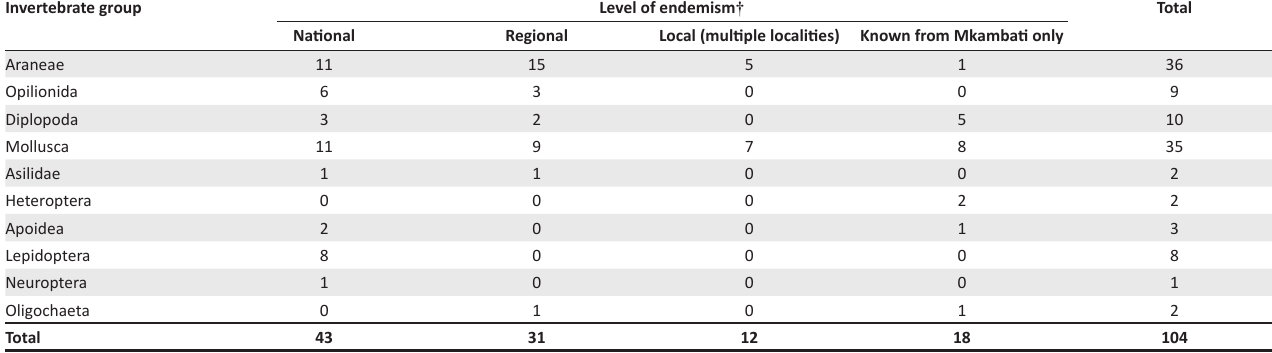
† , Levels of Endemism (2002): National = confined to South Africa; regional = confined to an area where the two furthest locality points are less than approximately 330 km apart, but greater than 60 km apart (these distances may be slightly larger in this assessment); local = multiple localities and these confined to an area where the two furthest points are less than 60 km apart (this distance may be slightly larger in this assessment).